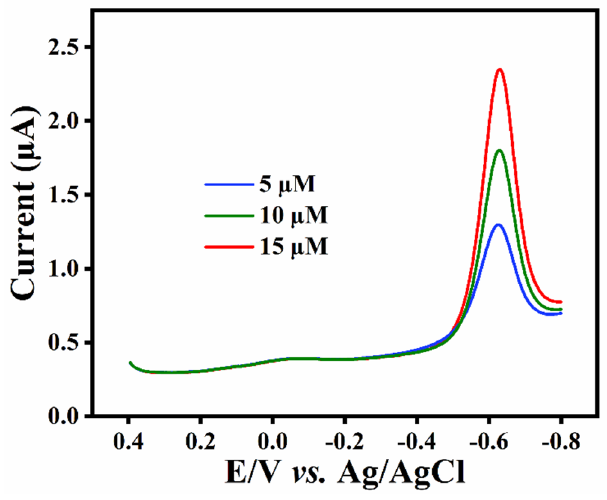
Figure 9. DPV curves recorded for ZTO/TO MPs/GCE in blood serum with added spikes of SCZ. Table 2. Practical analysis of SCZ in the blood serum sample at ZTO/TO MPs/GCE. Added ( µ M) Found ( µ M) Recoveries